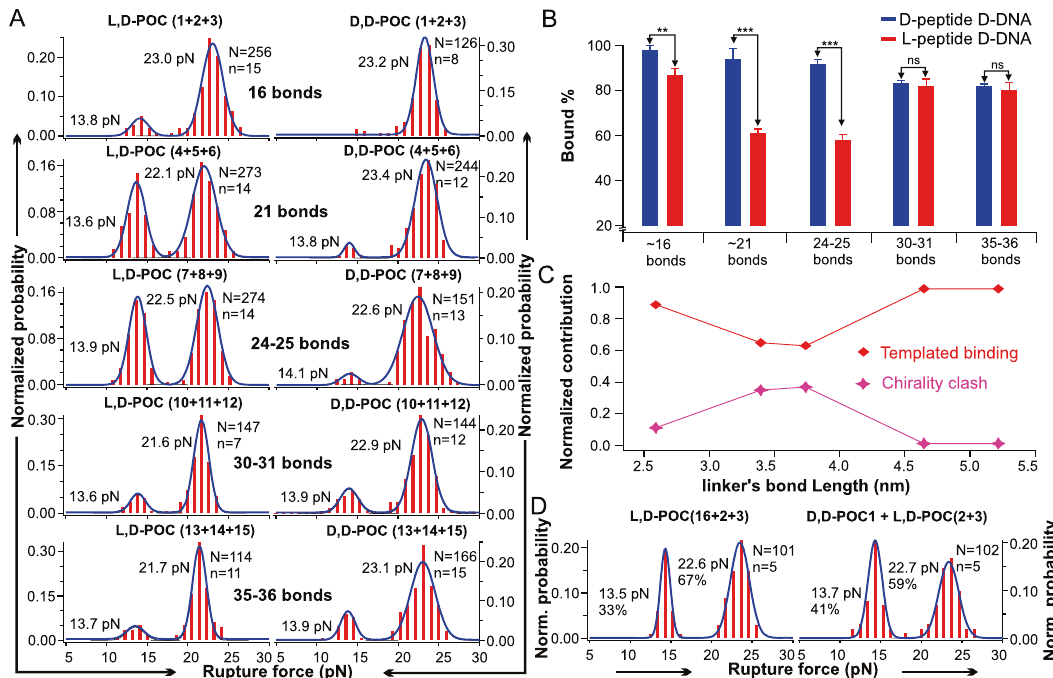
Fig. 4 Comparative study of bound % for the L- and D-peptide with different linker lengths. A Rupture force histograms for the L-peptide D-DNA (left) and D-peptide D-DNA (right) with varying linker length (in number of bonds). B Comparison of bound % for D-peptide D-DNA and L-peptide D-DNA. Data are presented as mean ± SD for n = 4 independent experiments. ** P = 0.0085, *** P = 3.9 × 10 − 5 for the 21 bonds and P = 2.4 × 10 − 5 for the 24 – 25 bonds, ns: nonsigni fi cant (two tailed unpaired t -test). C Percentage contribution of chirality clash and templated binding effects for the trimeric L-peptide D-DNA with varied linker length (see Methods for calculation). D Rupture force histograms for the L-peptide D-DNA ( L,D-POC(2 + 3) , 16 bonds) bound with a TFO conjugated with L-peptide ( L,D-POC16 , 44 – 45 bonds, left) or with D-peptide ( D,D-POC1 , 16 bonds, right). N and n depict total numbers of features and distinct molecules,